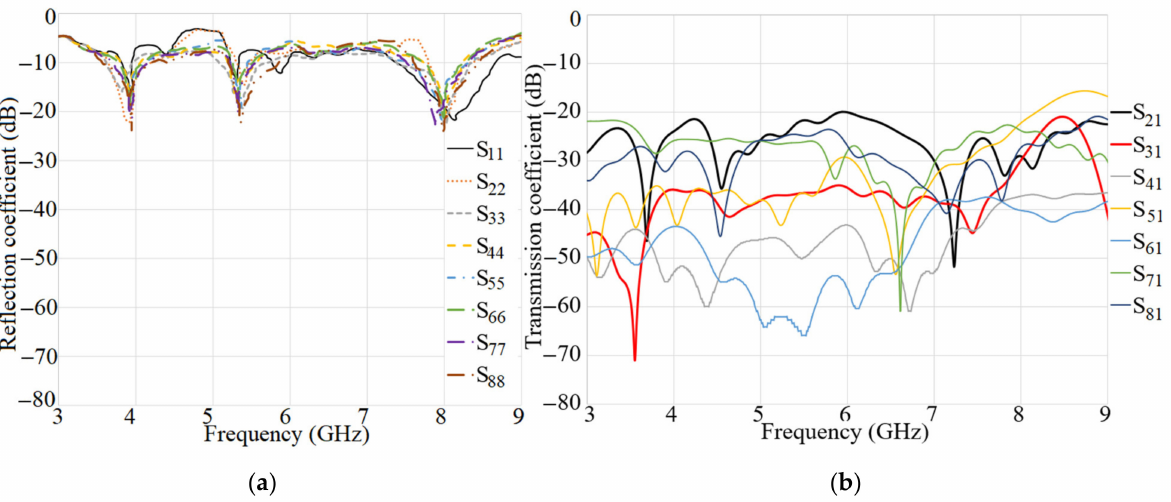
Figure 24. S-parameters of proposed MIMO antenna with head and hand models: ( a ) reflection coefficient and ( b ) transmission